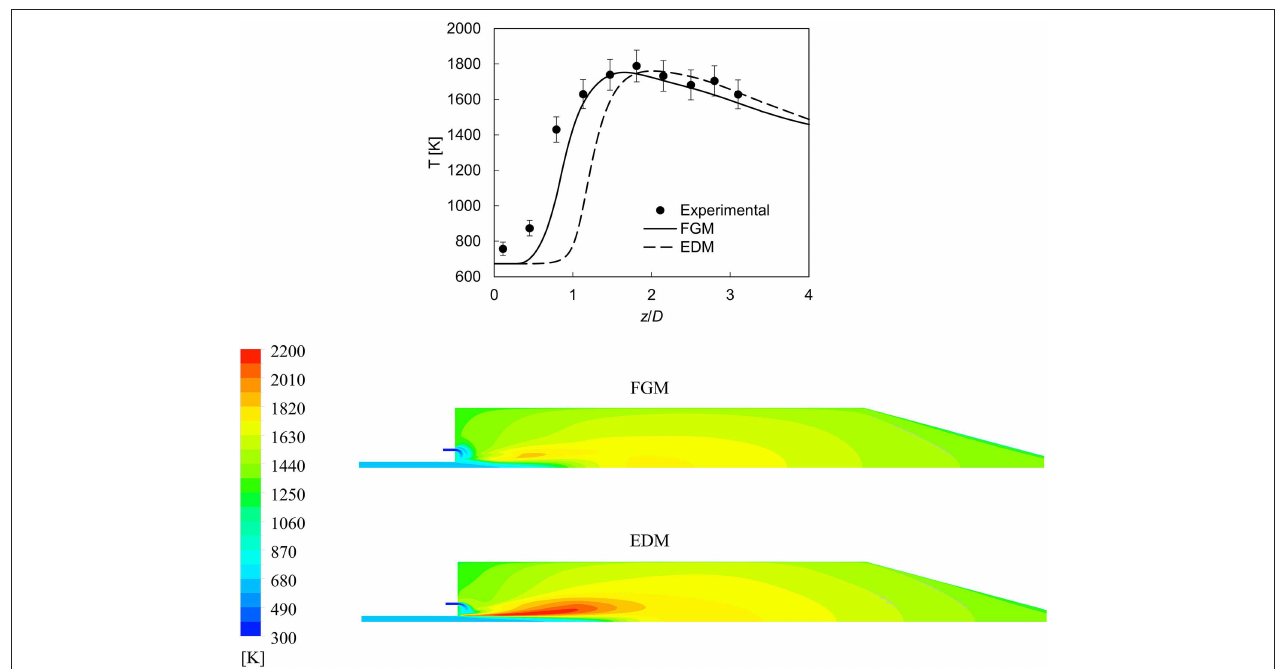
FIGURE 4 | Experimental and CFD temperature results along the centerline of the combustor ( Above ) and temperature contour plots ( Below ) for condition b ( φ ∼= 0.77) using FGM and EDM.